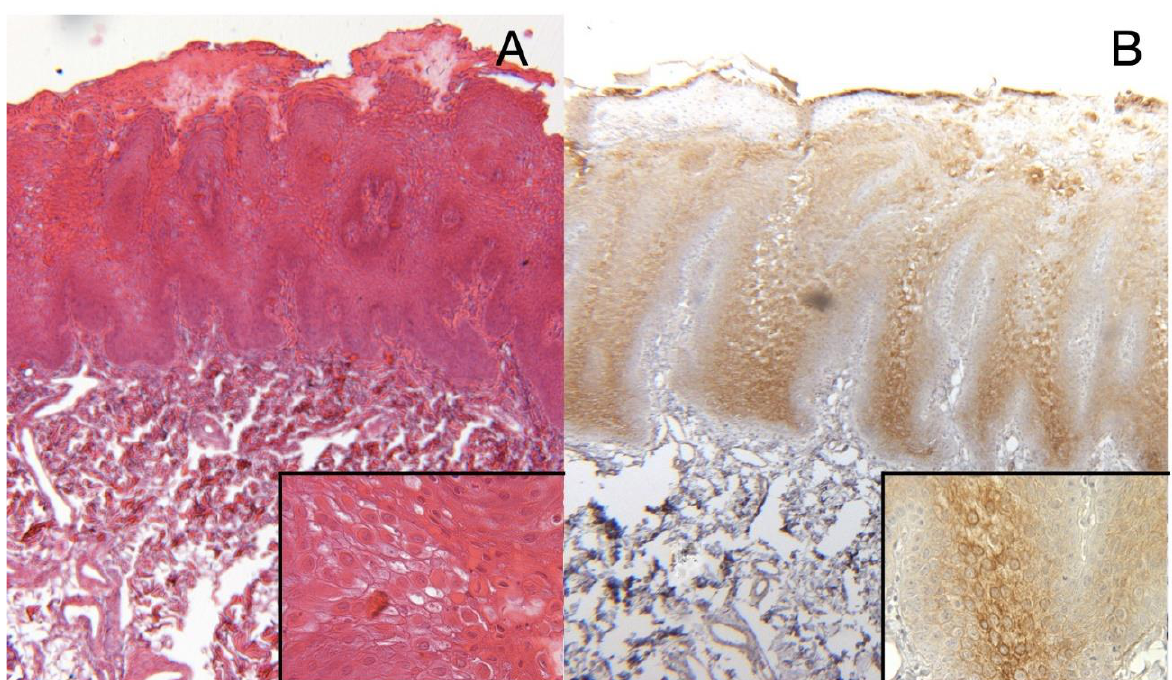
Figure 2. ( A )—Histological analysis of paraffin-embedded section from oral biopsy shows the presence of edema and acanthosis (H&E 4 × ); the lower half of the epithelium appears normal. No evidence of dysplasia and no basal cell degeneration. At higher magnification (in the lower box), cells of the prickle cell (spinous) layer displayed marked intracellular edema and nuclear pyknosis (H&E 40 × ). ( B )—Overexpression of KRT13 was observed in the same sample (CK13 immunohistochemistry 4 × and 40 × in the lower box).